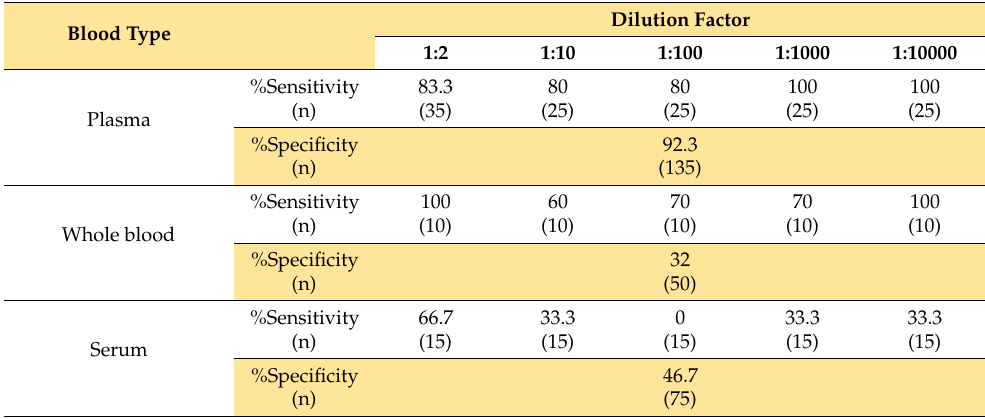
Table 3. A table summary of the sensitivity and specificity of ANN models developed to predict DENV1 in plasma, whole blood and serum and applied on the test